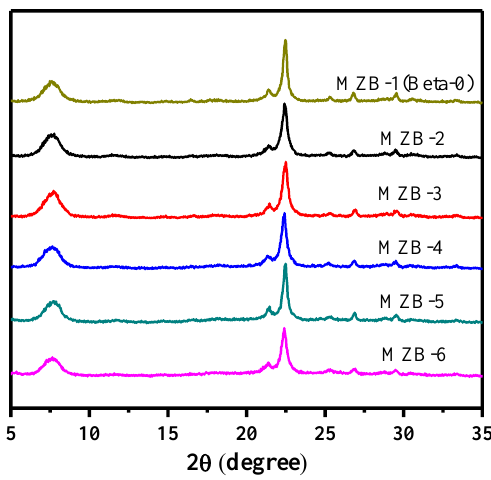
Figure 1. XRD patterns of as-synthesized zeolite Beta samples.